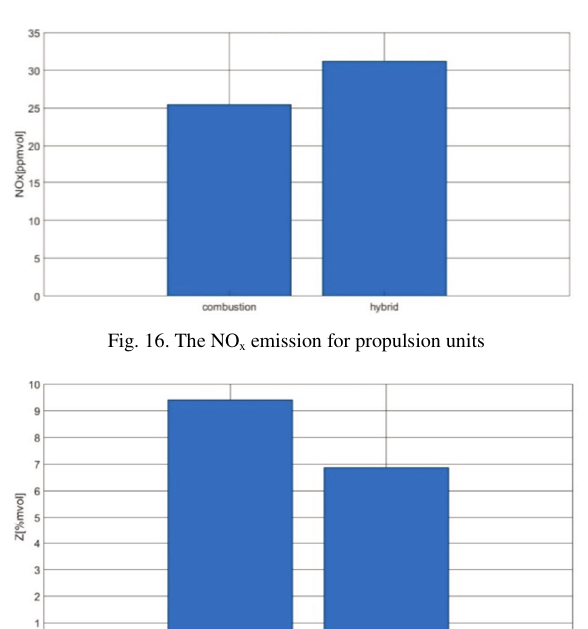
Fig. 15. The CO 2 emission for propulsion units